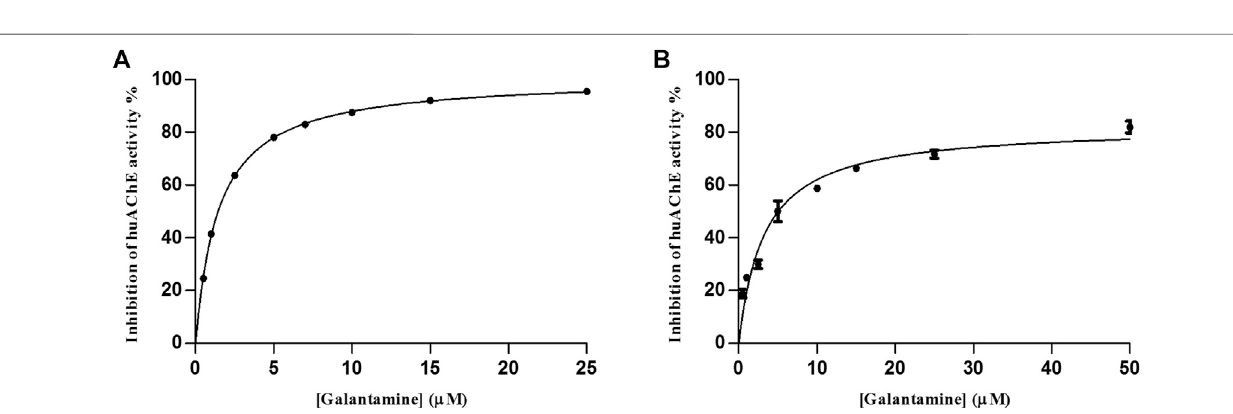
Frontiers in Chemistry |